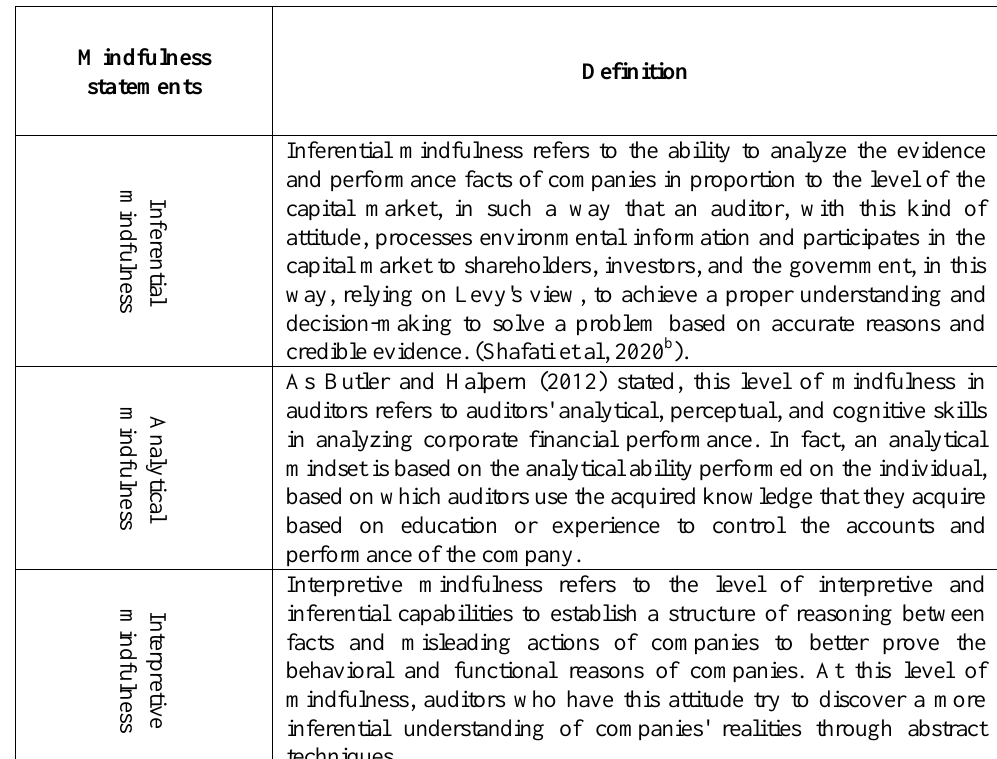
Table 6. Statements related to the mindset of